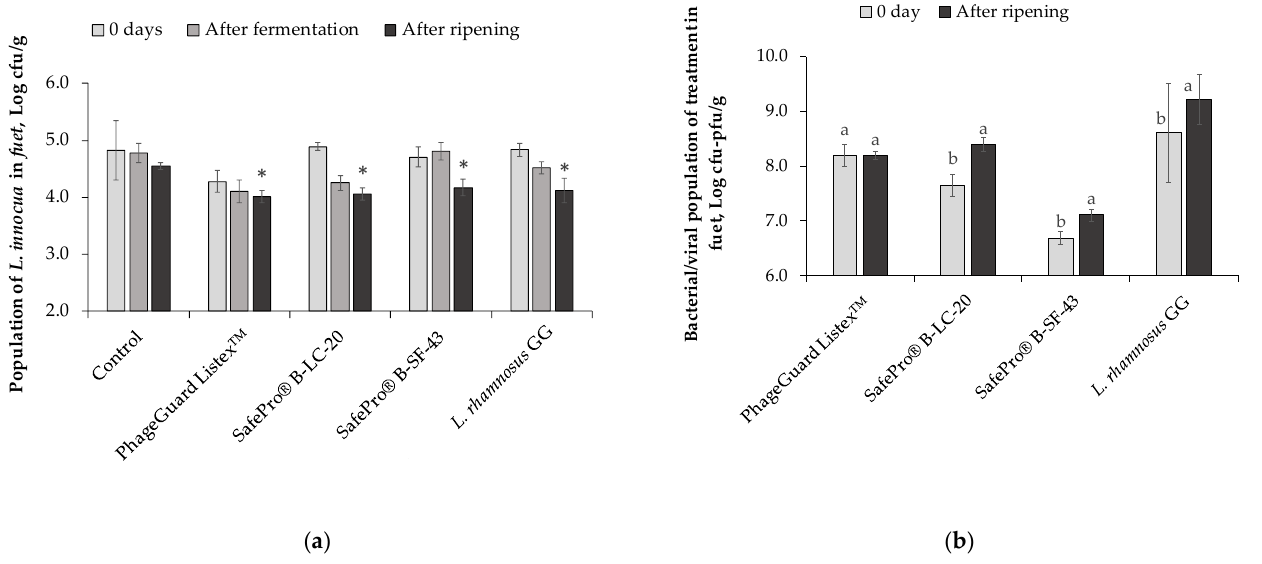
Figure 6. Effect of the biopreservative treatments in fuet : ( a ) L. innocua population in fuet at different time course of fuet production: inoculation day (0 day), after 24 h of fermentation, and at the end of ripening (7 days). Values are means ± standard deviations of three biological replicates. Bars marked with an asterisk represent statistically significant differences between the treatment and the control ( p < 0.05) at each sampling time. ( b ) Counts of bacteriophage P100 (formulated in PhageGuard Listex TM treatment), P. acidilactici (formulated in SafePro ® B-SF-20 treatment), Leuc. carnosus (formu- lated in SafePro ® B-SF-43 treatment), and L. rhamnosus GG in fuet after inoculation and at the end of ripening. Values are means ± standard deviations of three biological replicates. Bars marked with different letters (a and b) represent statistically significant differences among sampling time ( p < 0.05) at each evaluated treatment.